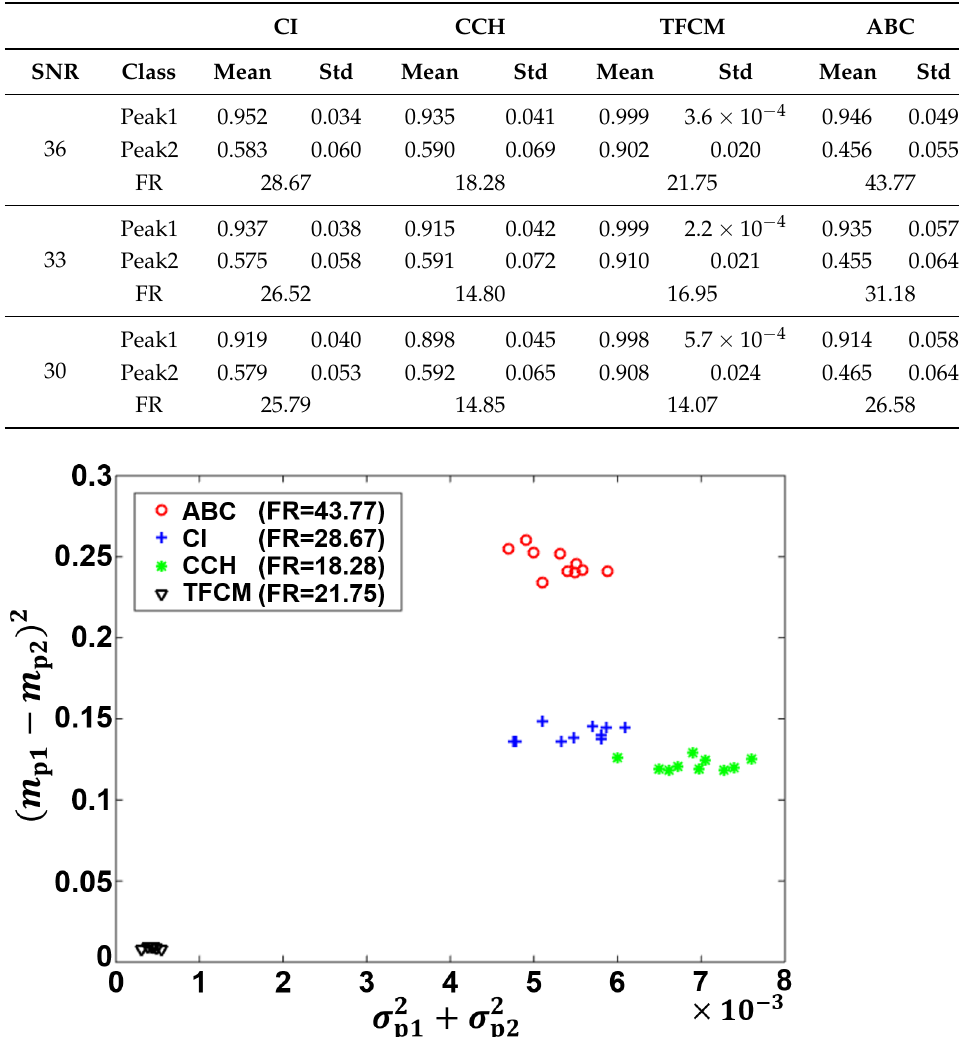
Figure 10. Analytical diagram of FR ( SNR =